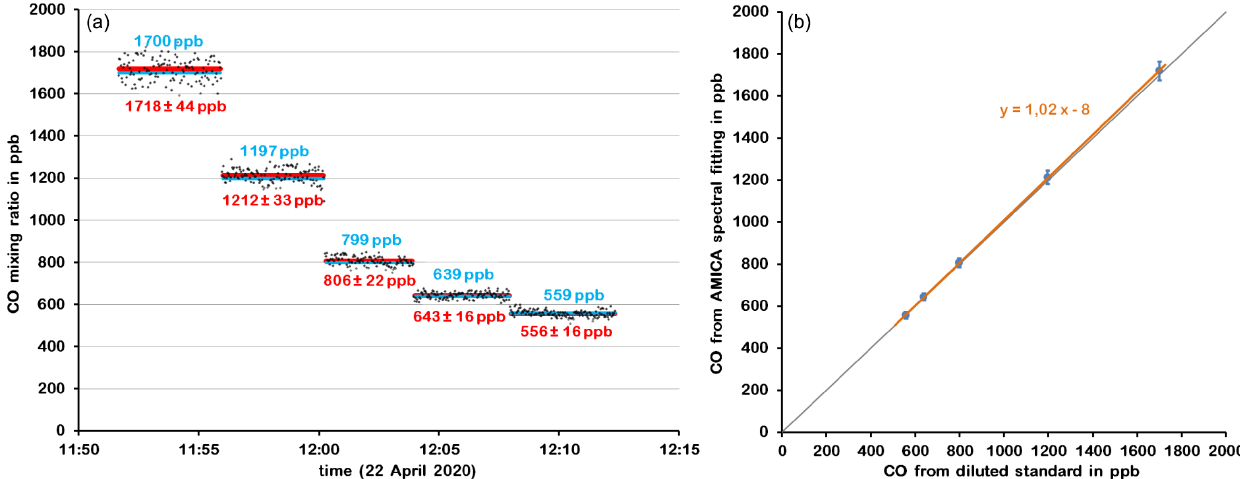
Figure 8. Panel (a) shows the CO mixing ratios fitted to AMICA spectra (black: individual data points; red: averaged with standard devia- tions) and the known mixing ratios in the standards (light blue) against time of the experiment. Panel (b) shows AMICA CO vs. standard CO and a linear fit of these data.